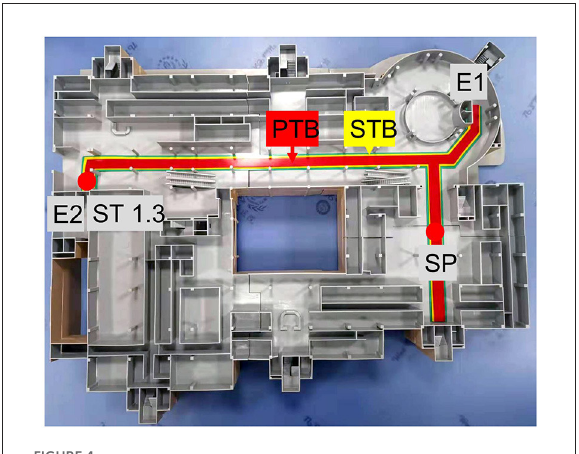
FIGURE4 PTB and STB for the IHT model. A transportation pathway for a patient and a team member is marked in red. By-standers should be restricted to the yellow